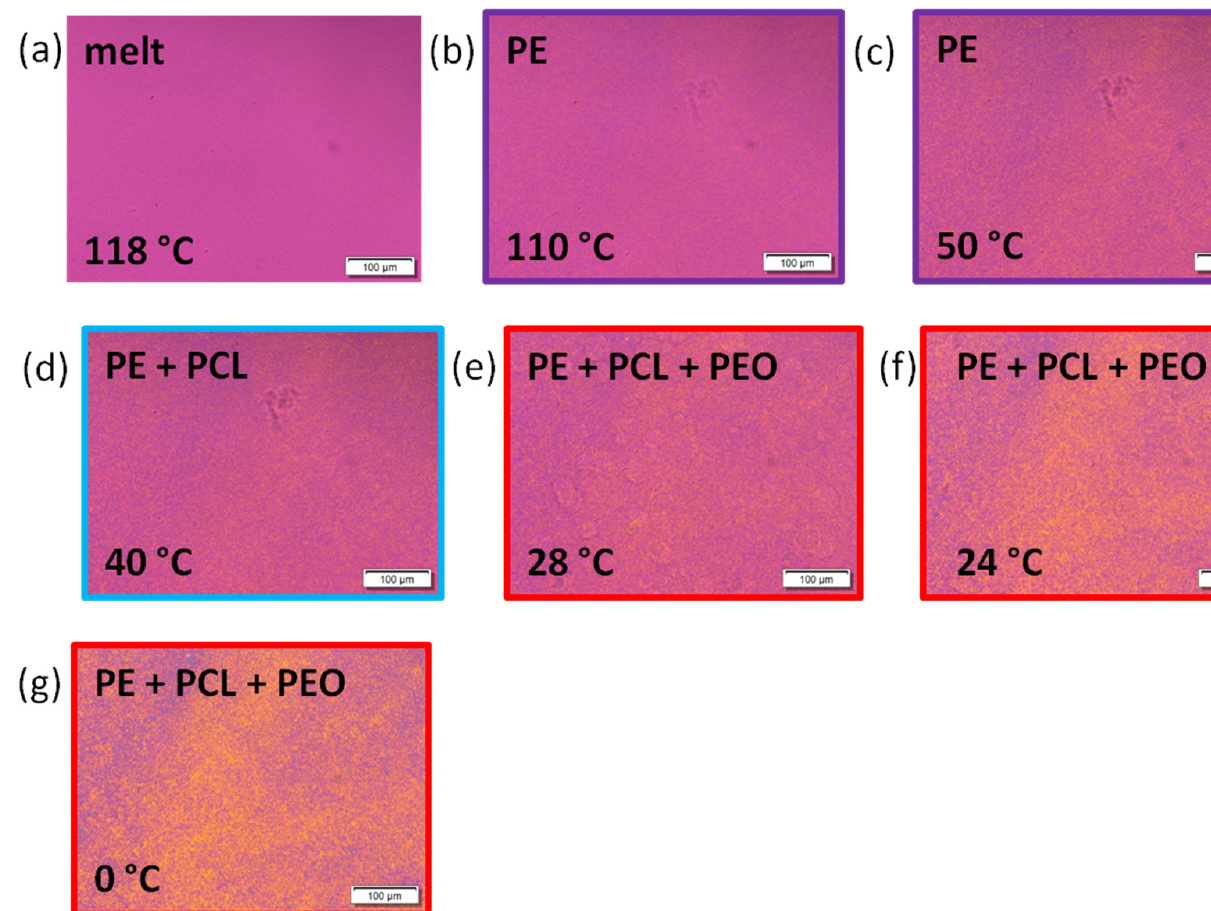
Figure 13. PLOM micrographs of the triblock terpolymer PE 379.5 -b- PEO 348.8 -b- PCL 297.6 (T2) cooling the sample from the melt at a constant rate of 20 °C/min. Colored squares (violet for PE, blue for PCL, and red for PEO) refer to the crystallized block at the corresponding temperature indicated on the top of the micrographs for ( a ) molten state at 118 °C, ( b ) PE at 110 °C, ( c ) PE at 50 °C, ( d ) PE and PCL at 40 °C, ( e ) PE, PCL, and PEO at 28 °C, ( f ) PE, PCL, and PEO at 24 °C, and ( g ) PE, PCL, and PEO at 0 °C.